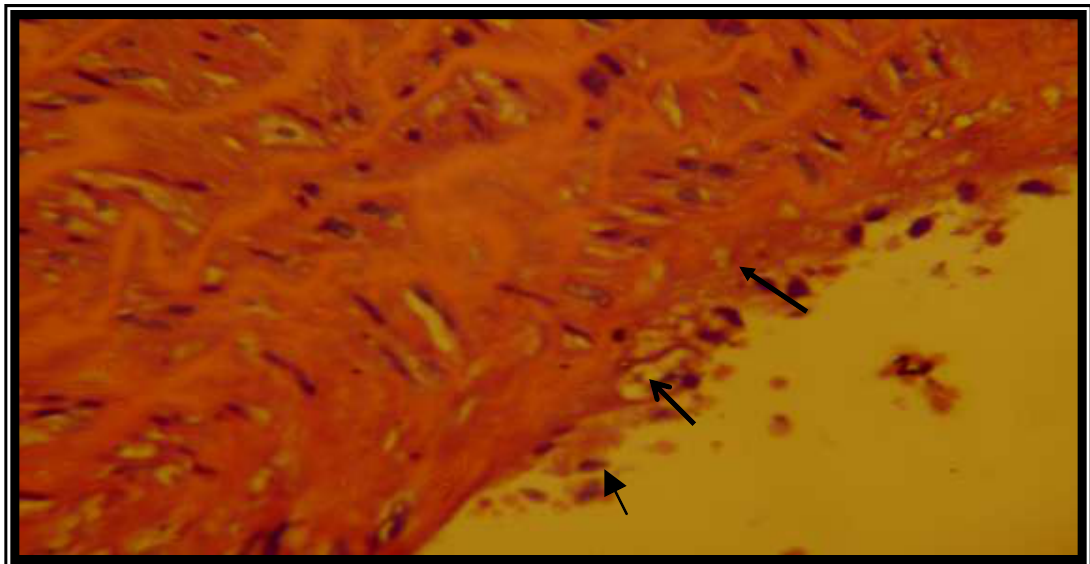
Figure (6) Histological section in Aorta of H2O2 treated rats note: irregular of intima ( ), with inflammatory cells attachment to it’s (